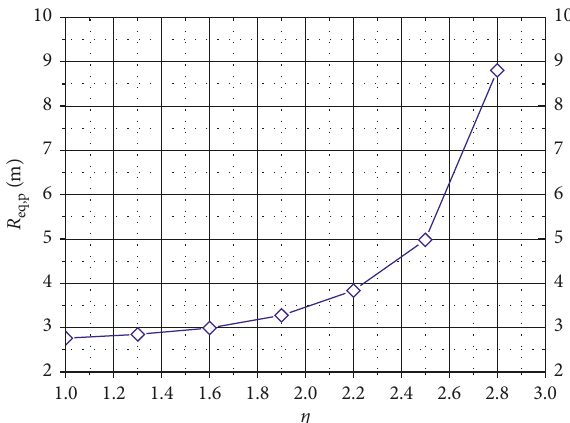
Figure 13: The relation curves for η - R